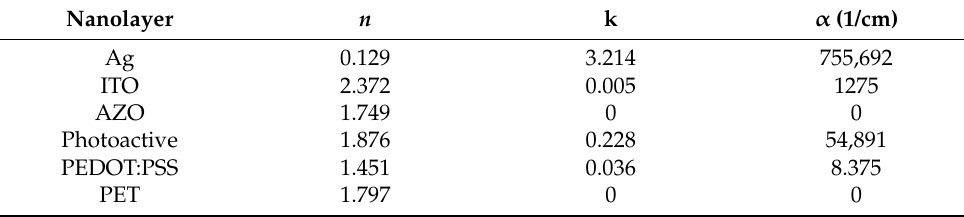
Table 1. OPV structure, materials and their optical properties at 532